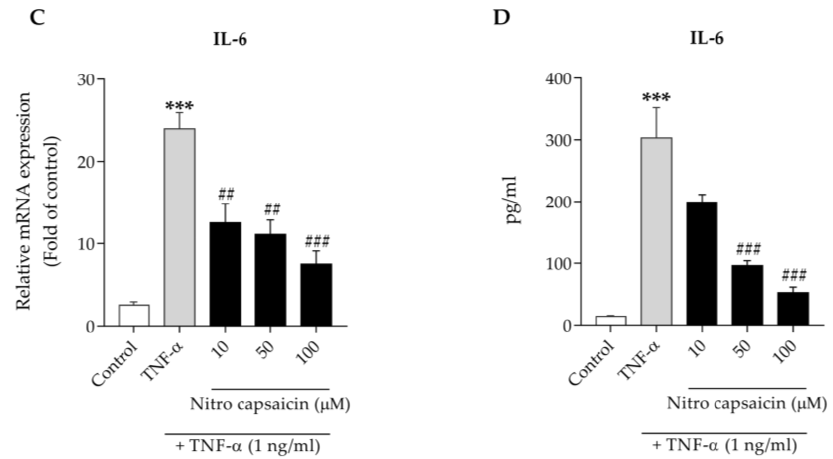
Figure 6. Effects of nitro capsaicin against TNF- α -induced proinflammatory cytokine production in hCMEC/D3 cells. Nitro capsaicin decreased mRNA expression of ( A ) IL-1 β and ( C ) IL-6. Nitro capsaicin reduced release of the cytokines ( B ) IL-1 β and ( D ) IL-6. The control was DMSO treatment. * p < 0.05 and *** p < 0.001 versus control group; # p < 0.05, ## p < 0.01, and ### p < 0.001 versus TNF- α -treated group.